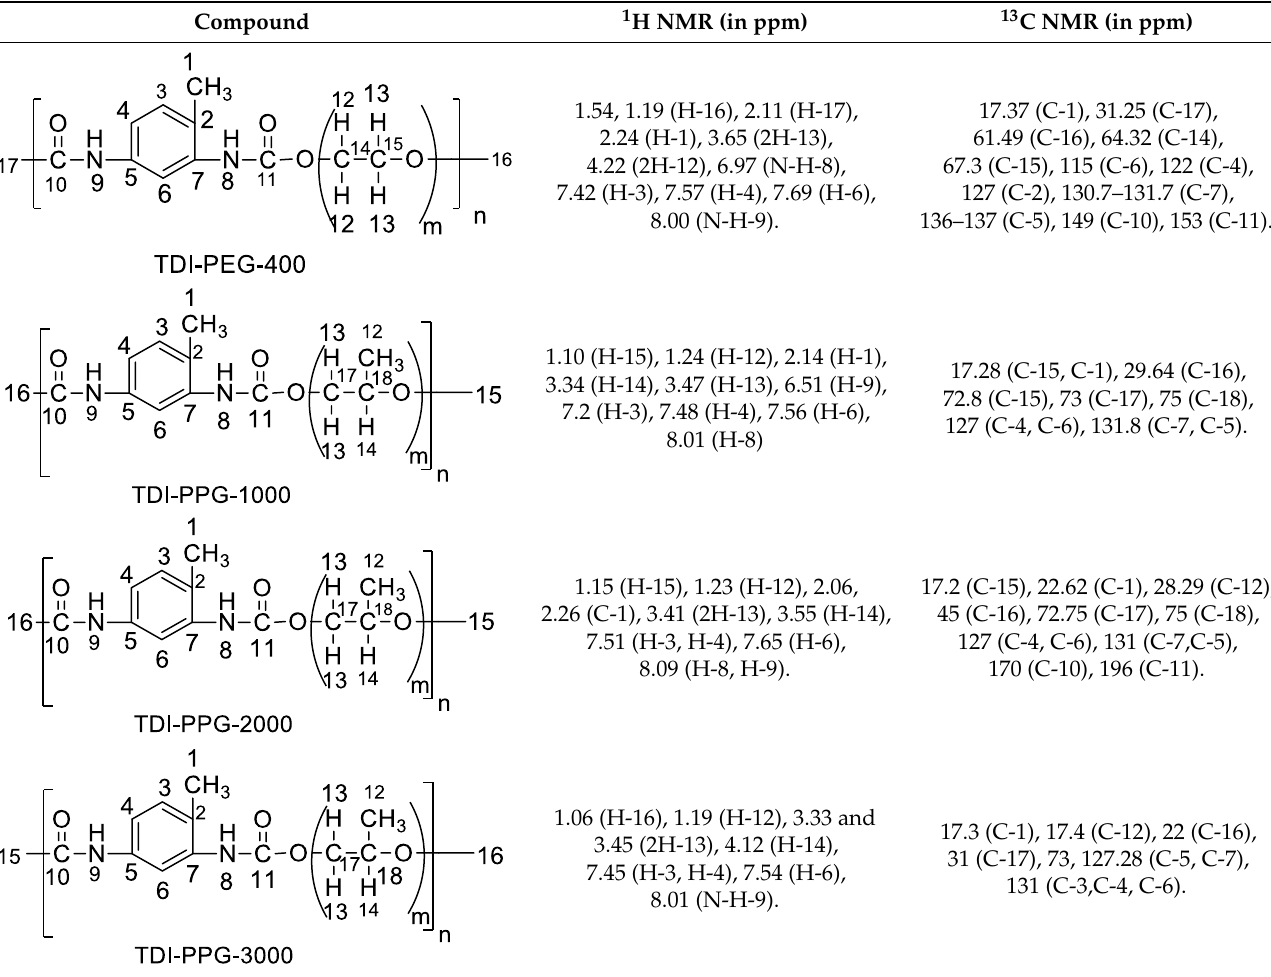
Table 4. NMR spectra of polyurethane from blocked TDIwith3-(4-bromophenyl)-1H-pyrazole. Compound